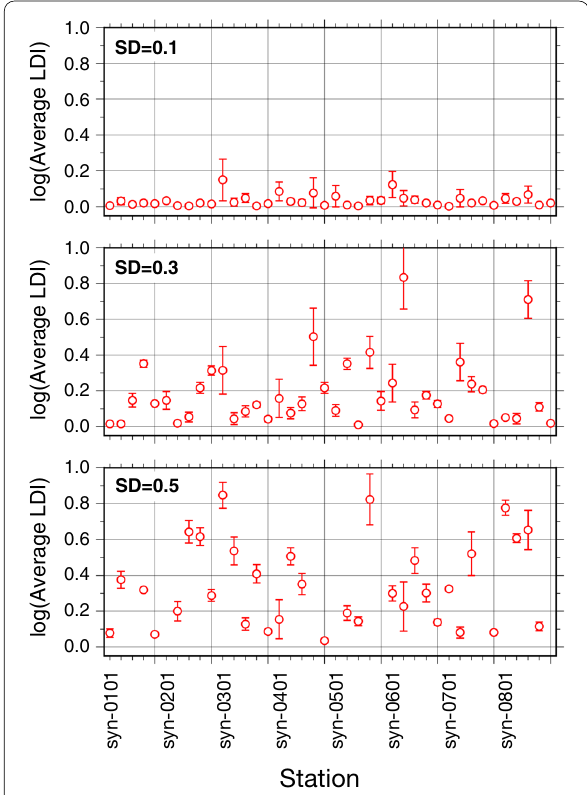
Fig. 6 Average LDIs (red circles with error bars) obtained from a synthetic data set distorted using GB parameters with SD values of 0.1, 0.3, and